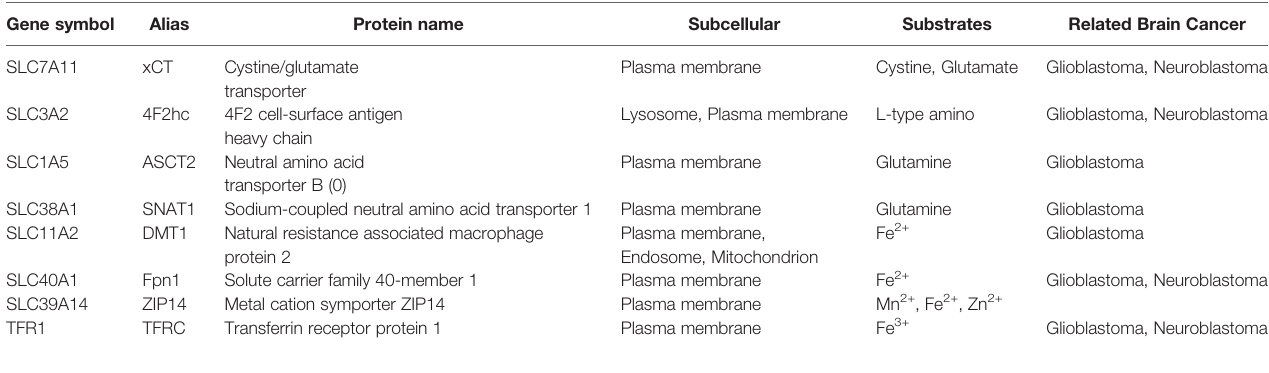
TABLE 3 | The characteristics of ferroptosis-related transport protein associated with malignant brain